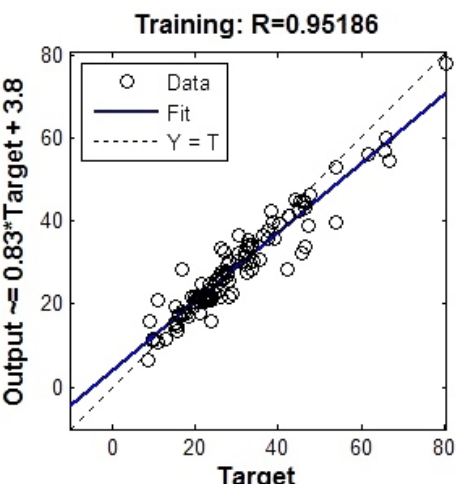
Fig. 8. Relationship between the Target and Output Values in the Training Step of ANN